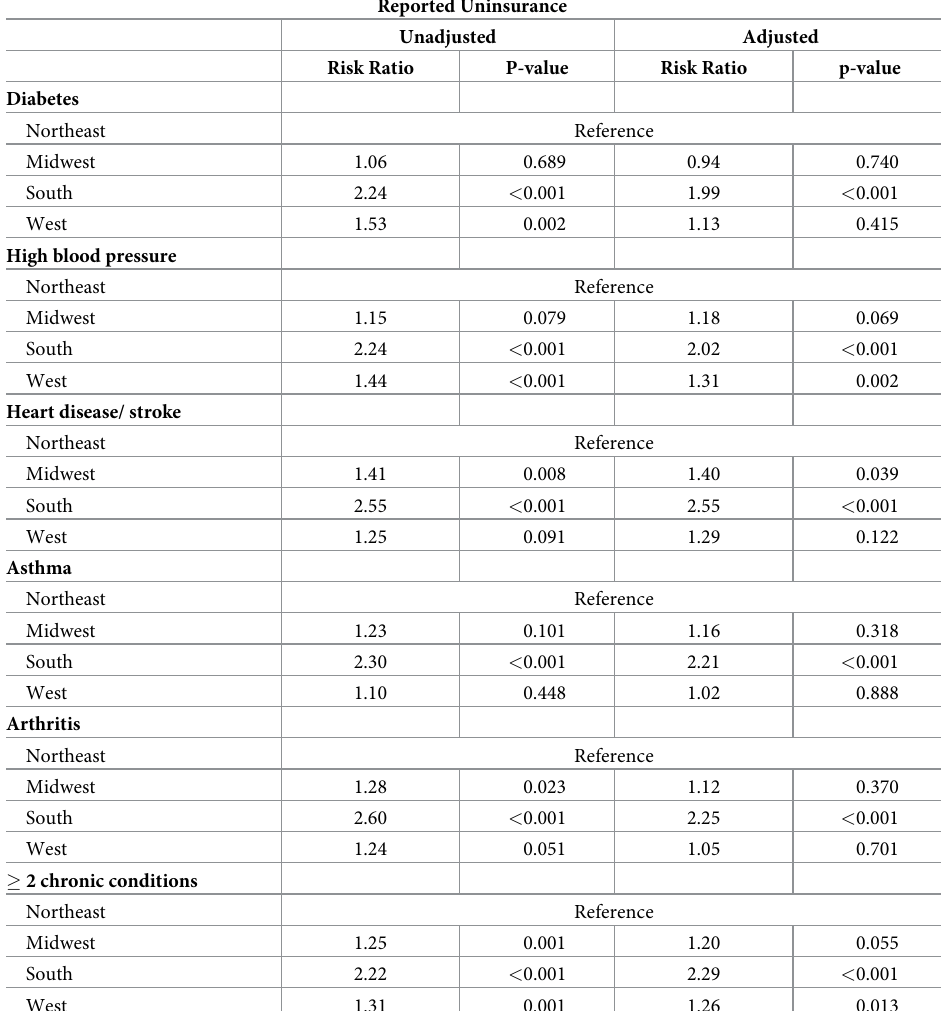
Table 3. Likelihood of being uninsured post-ACA by US Census Region for individuals ages 18-64 with each select chronic condition, MEPS survey data